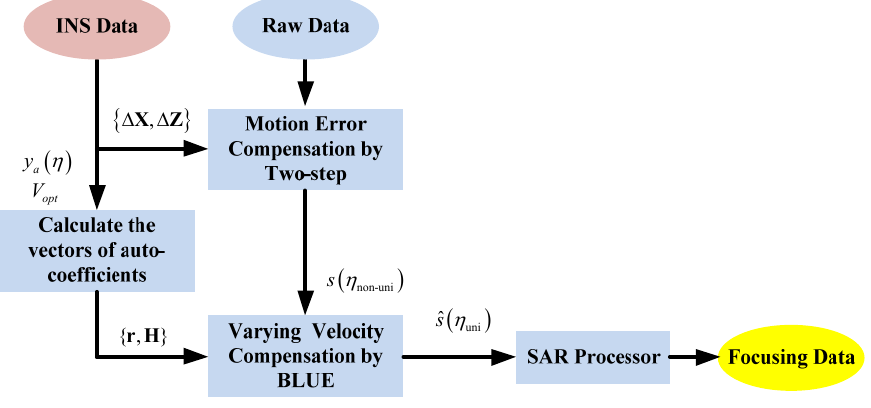
Figure 3. Blocks of the BLUE processing procedures.